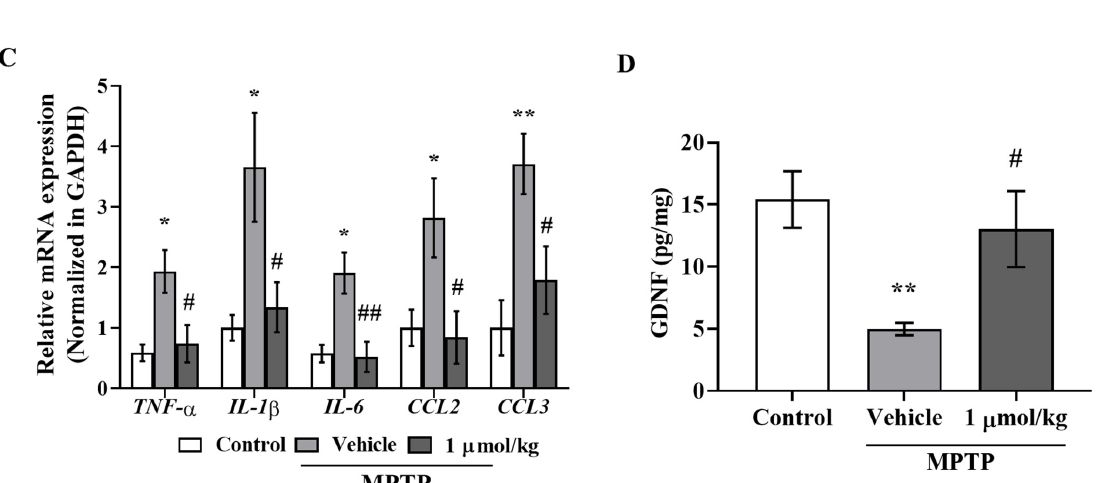
Figure 5. IAGIP reduced MPTP-induced astroglial activation in the striatum. ( A ) STR sections were double immunostained using GFAP (astrocyte marker) and Iba-1 (microglia marker) antibodies. Representative images in the top row showed the overall expression patterns of GFAP and Iba-1, and high magnification images were stacked z-sections. Scale bar = 50 µ m. ( B ) Quantitative analysis of GFAP (green) and Iba-1 (red) fluorescence intensities. Results are presented as means ± SEs ( n = 5–6 mice/group). *** p < 0.001 vs. vehicle-treated controls and ### p < 0.001 vs. MPTP-treated controls. ( C ) RT-PCR showed that IAGIP significantly reduced MPTP-induced inflammatory cytokine and chemokine levels in STR. Values are means ± SEs ( n = 3–6 mice/group). ** p < 0.01 and * p < 0.05 vs. vehicle-treated controls, and ## p < 0.01 and # p < 0.05 vs. MPTP-treated controls. ( D ) GDNF levels in STR were assessed by ELISA. Values are means ± SEs ( n = 5–6 mice/group). ** p < 0.01 vs. vehicle-treated controls and # p < 0.05 vs. MPTP-treated